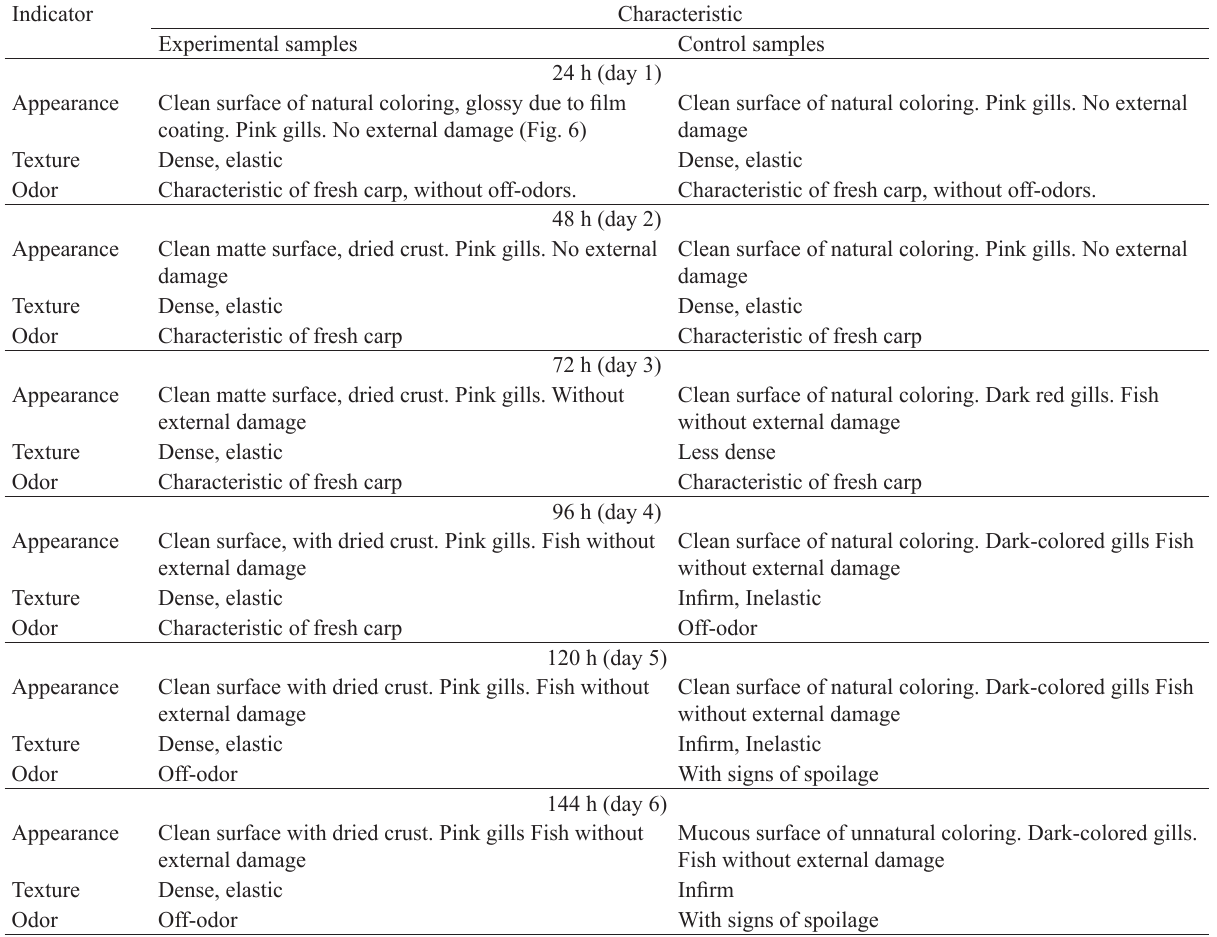
Table 5 Sensory indicators of carp during six-day storage Indicator Characteristic Experimental